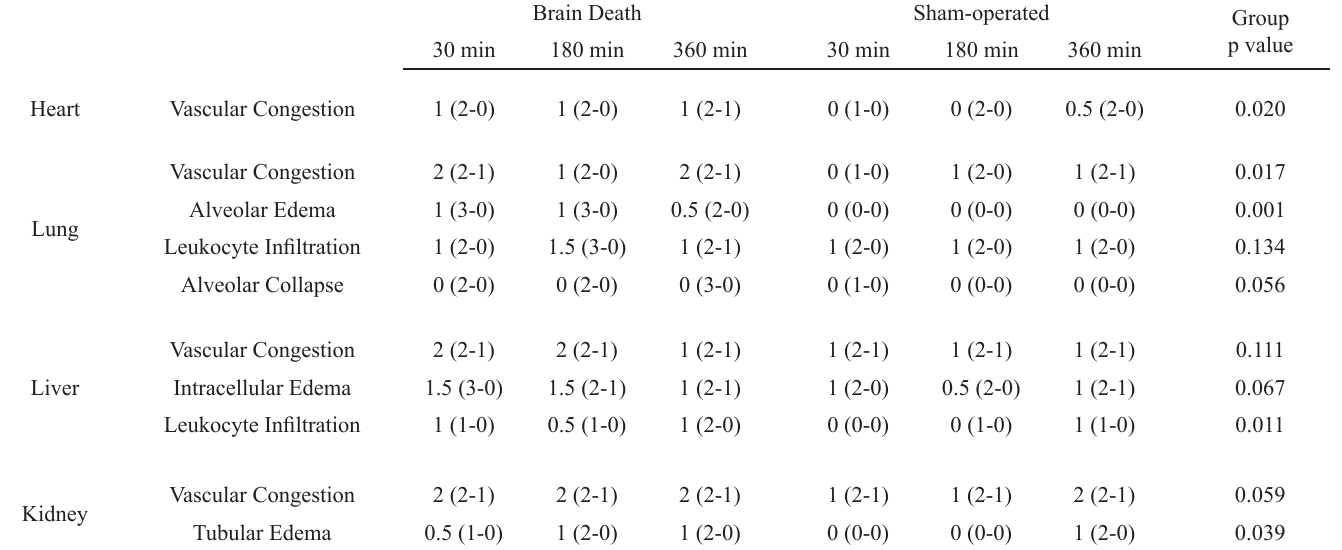
TABLE 1 - Histological injury